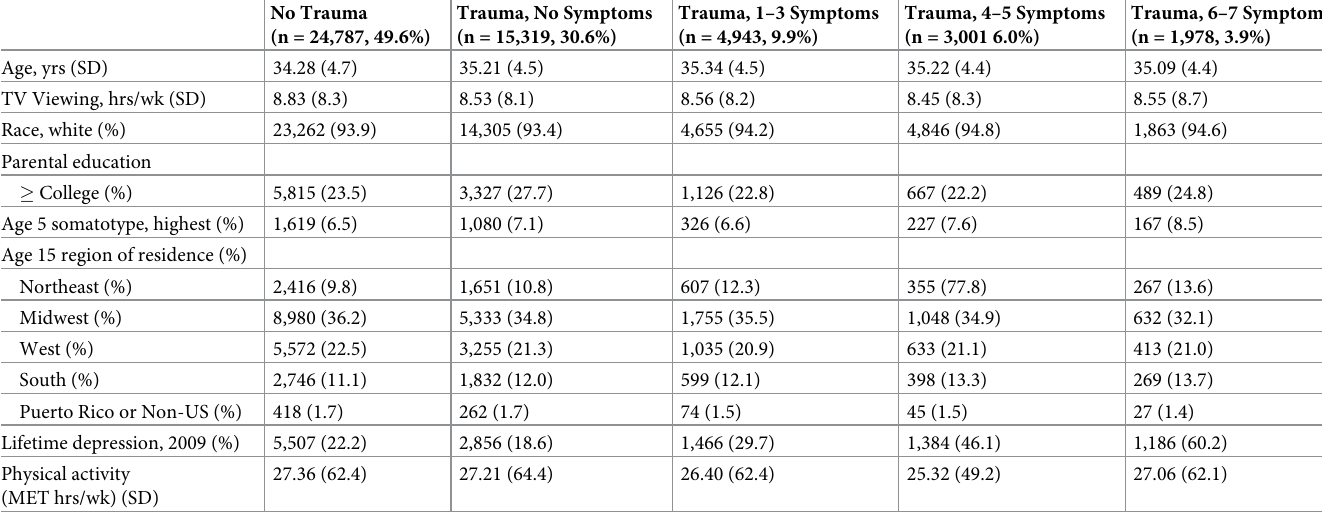
Table 1. Sample characteristics at baseline (1989), stratified by number of symptoms of posttraumatic stress disorder (N = 50,020). No Trauma (n = 24,787,